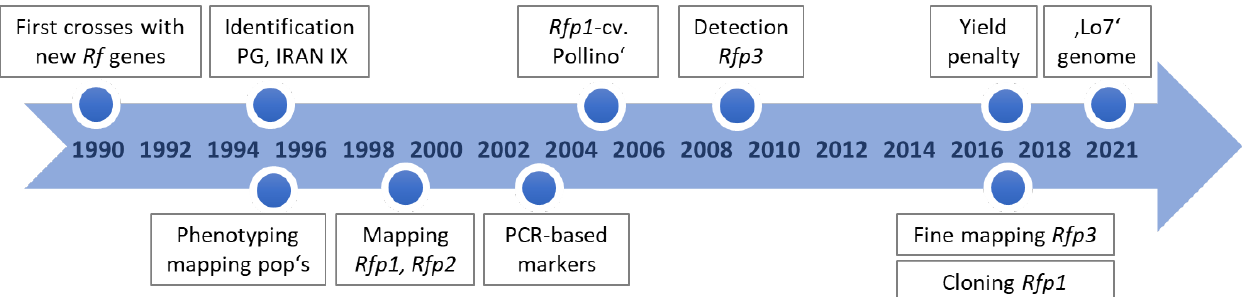
Figure 4. Time course of detection and phenotypic and molecular analyses of effective, non-adapted restorer genes.